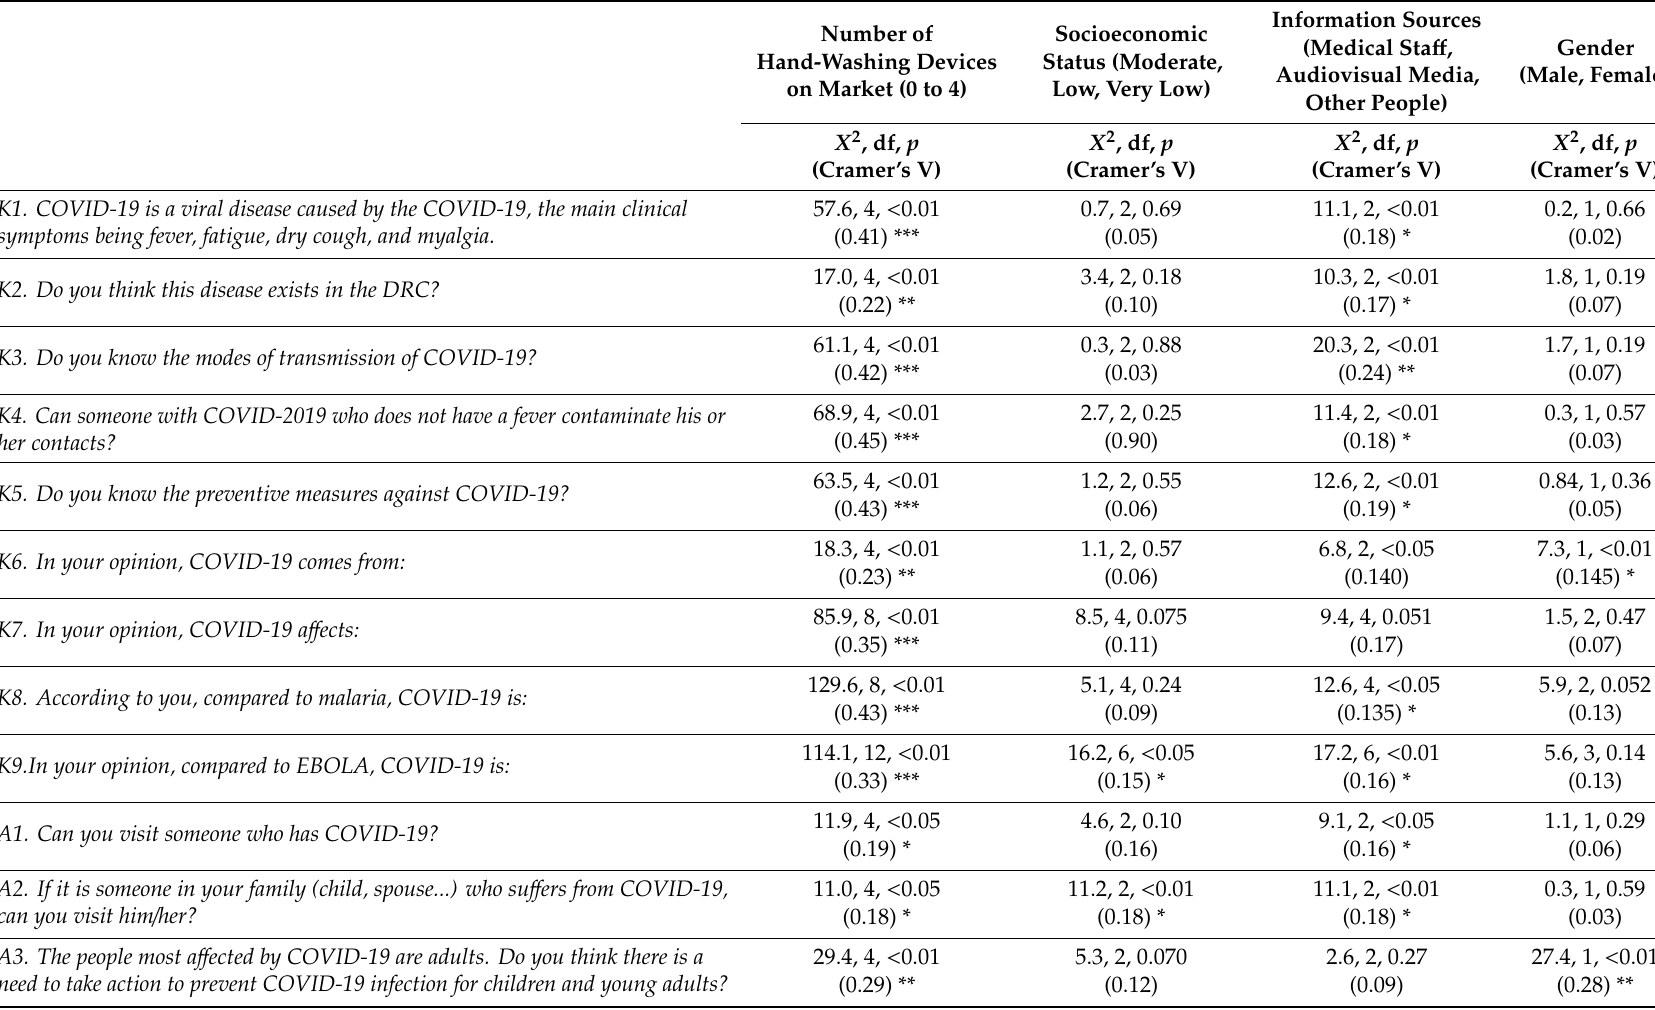
Table 3. Association between personal characteristics and responses to questionnaire surveys and observations made between 16 and 29 April 2020 on ten markets in four locations of the former Katanga province of DR